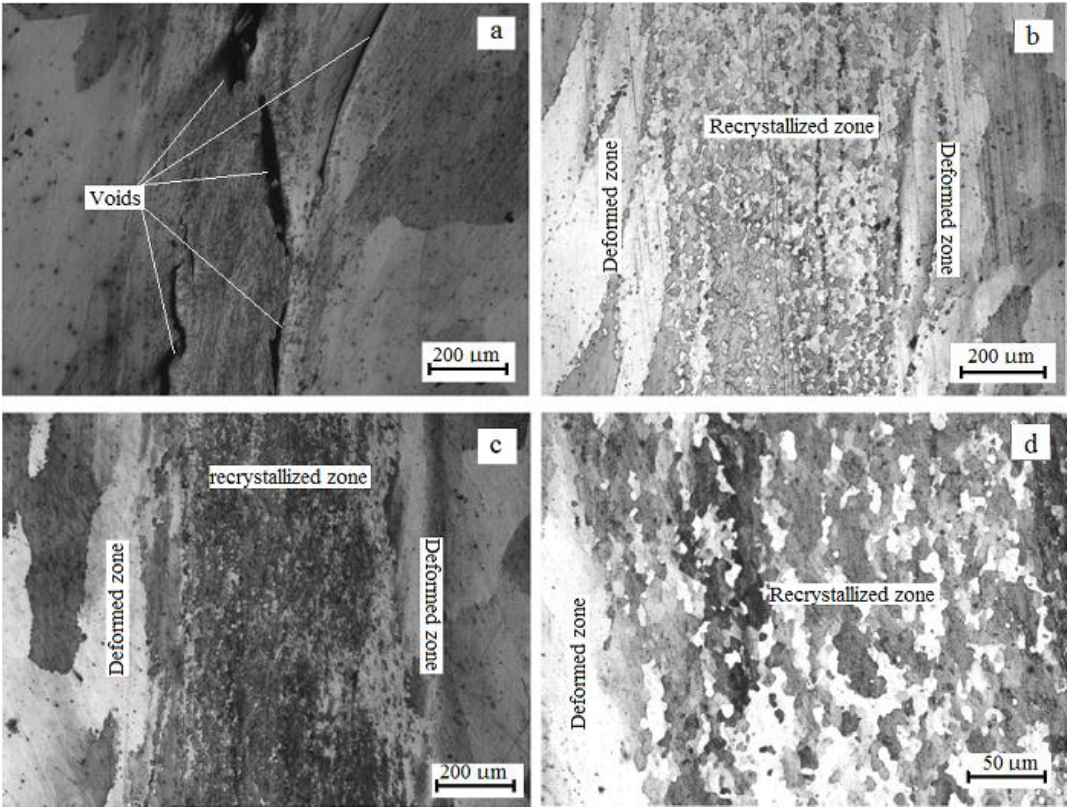
Figure 3. Optical micrographs of the welded samples under 200 MPa forging pressure and 140 MPa friction pressure. ( a ) 3 s; ( b ) 5 s; ( c ) 7 s; ( d ) higher magnification for 5